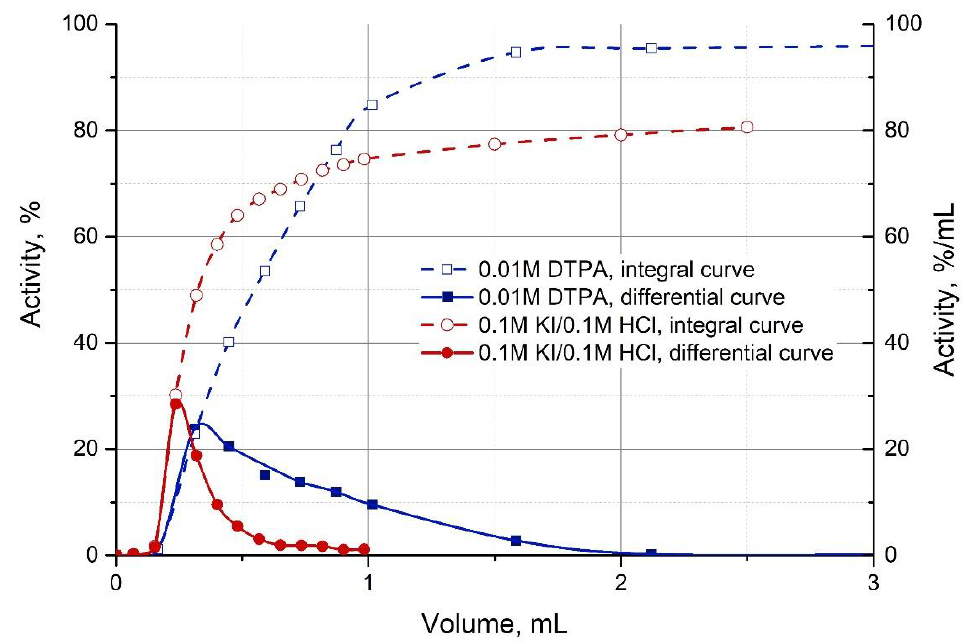
Figure 10. Integral (% of activity in the eluate, dashed lines) and differential (%/mL, solid lines) Bi elution curves with 0.1M HCl/0.1M KI and 0.01M DTPA (pH 5.3) from the column with 0.33–0.4 mL AG MP-50. Flow rate—1.0 ± 0.1 mL/min. 213 Bi activity was corrected for decay.